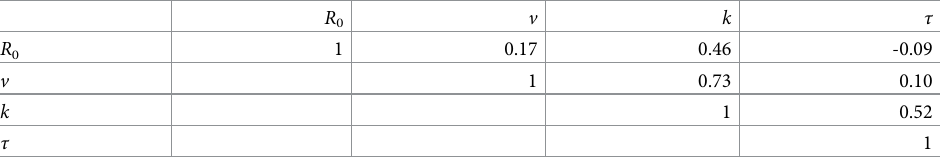
Table 2. Correlation coefficients measured between the 20 bestfit parameters of our model. Since the matrix is sym- metric with ones on the diagonal we only show its upper half. R 0 v k τ R 0 1 0.17 0.46 v 1 0.73 0.10 k 1 0.52 τ